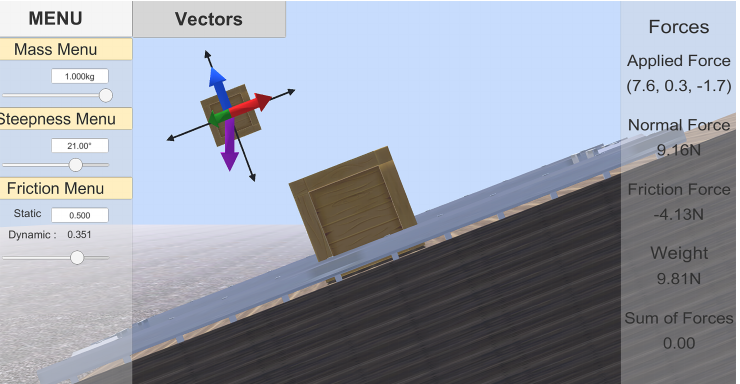
Figure 6. Interface elements for the “block on a rough incline” visuo-haptic environment developed with VIS-HAPT and HaDIU .